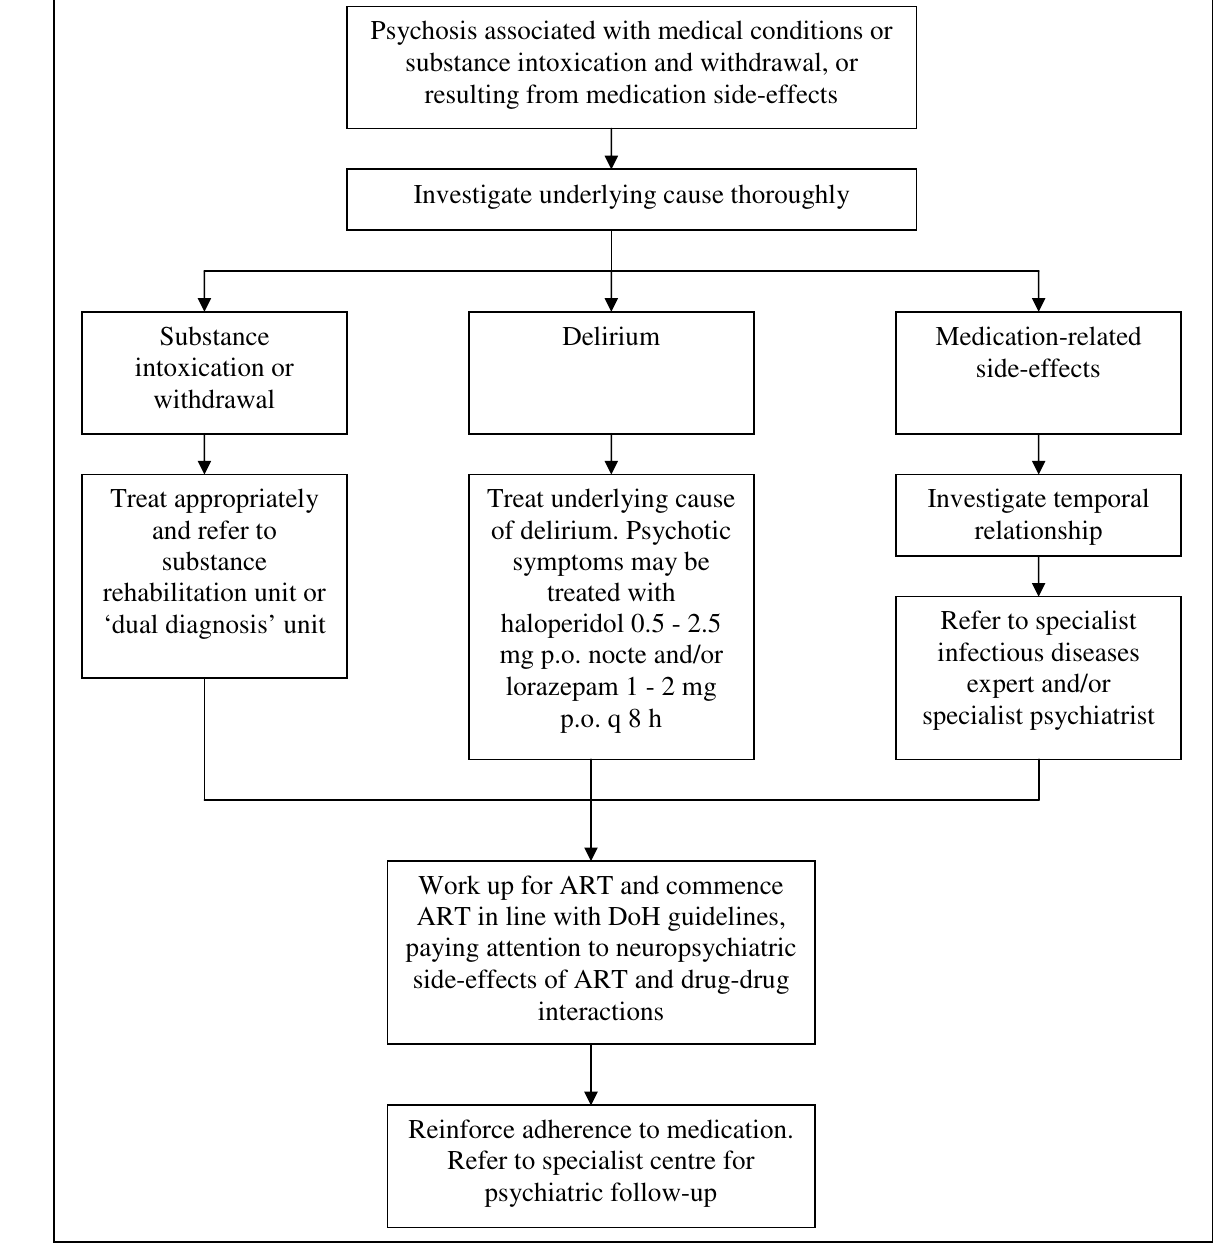
Fig. 4. Psychosis associated with medical conditions or substance intoxication/withdrawal, or resulting from medication- related